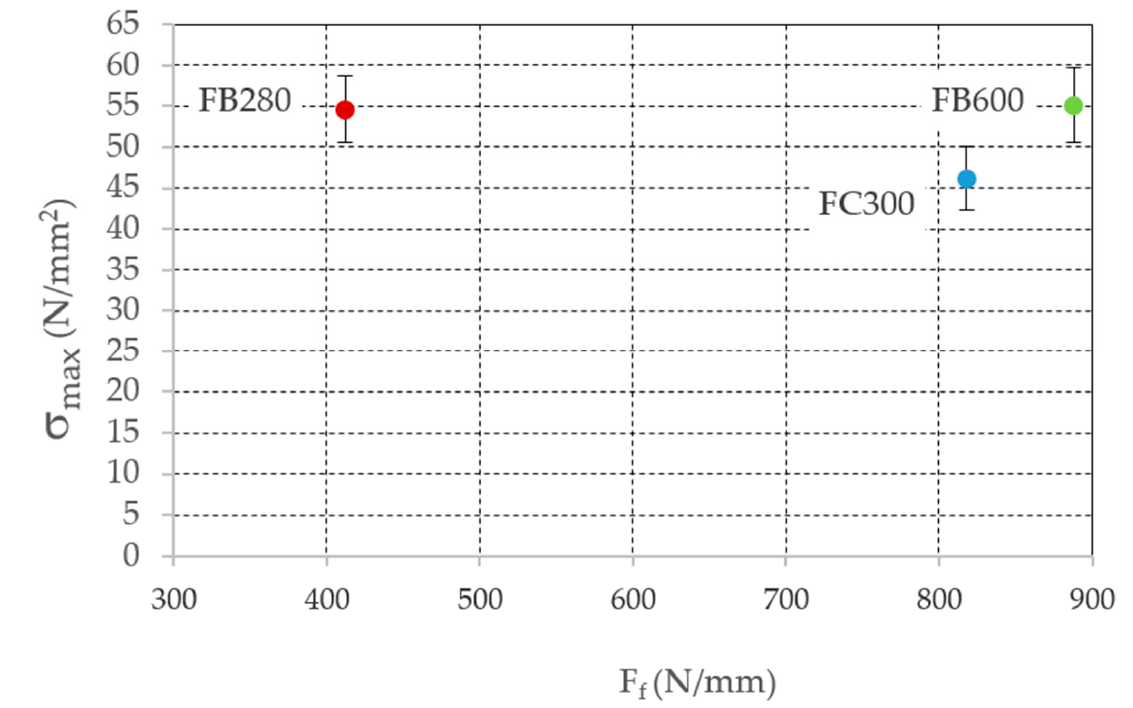
Figure 5. Relationship between the maximum strengths reached and the mechanical capacity of the reinforcements.